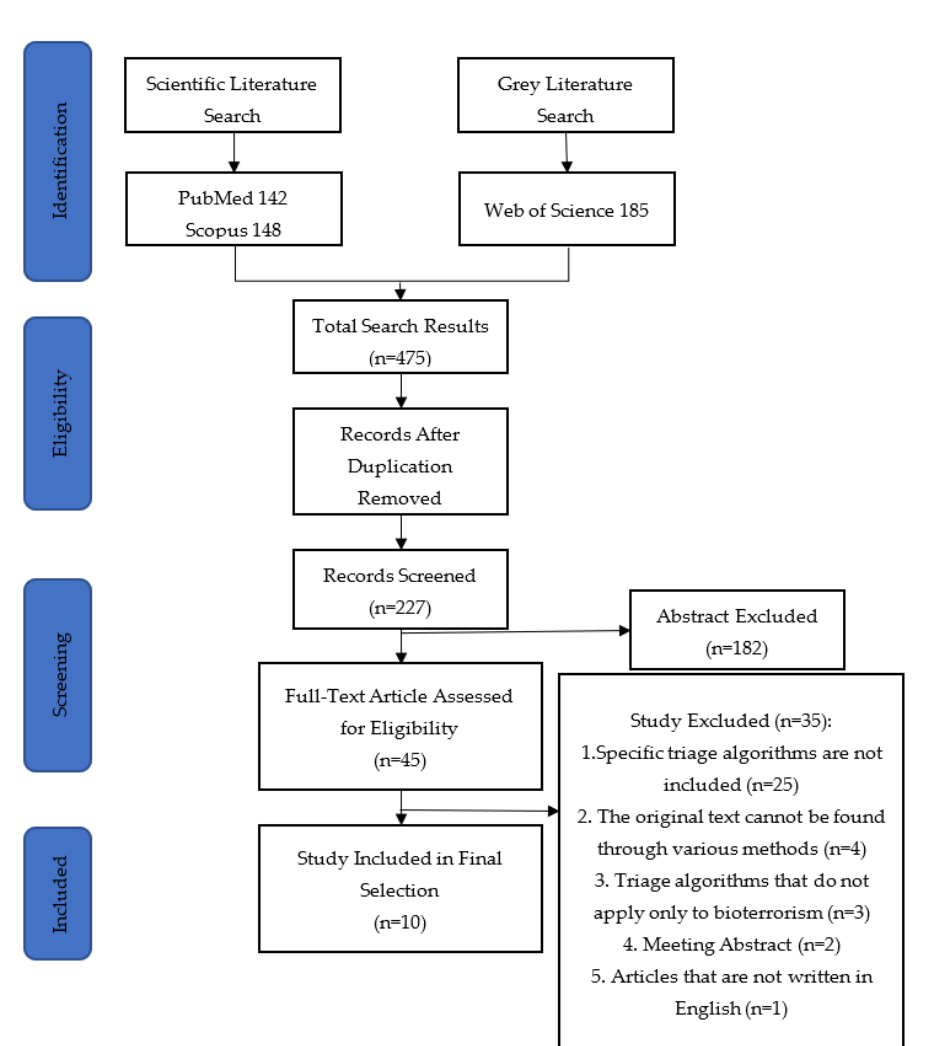
Figure 1. Flow diagram of the study selection process.